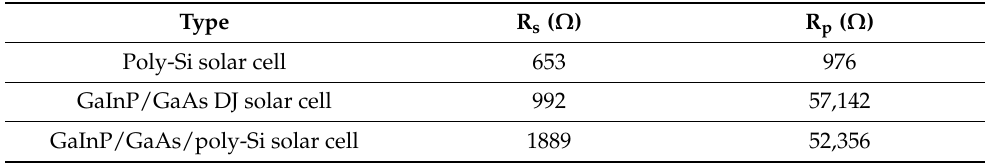
Table 3. Series and parallel resistances of ploy-Si, GaInP/GaAs DJ and GaInP/GaAs/poly-Si triple- junction solar cells obtained from the J–V curve.